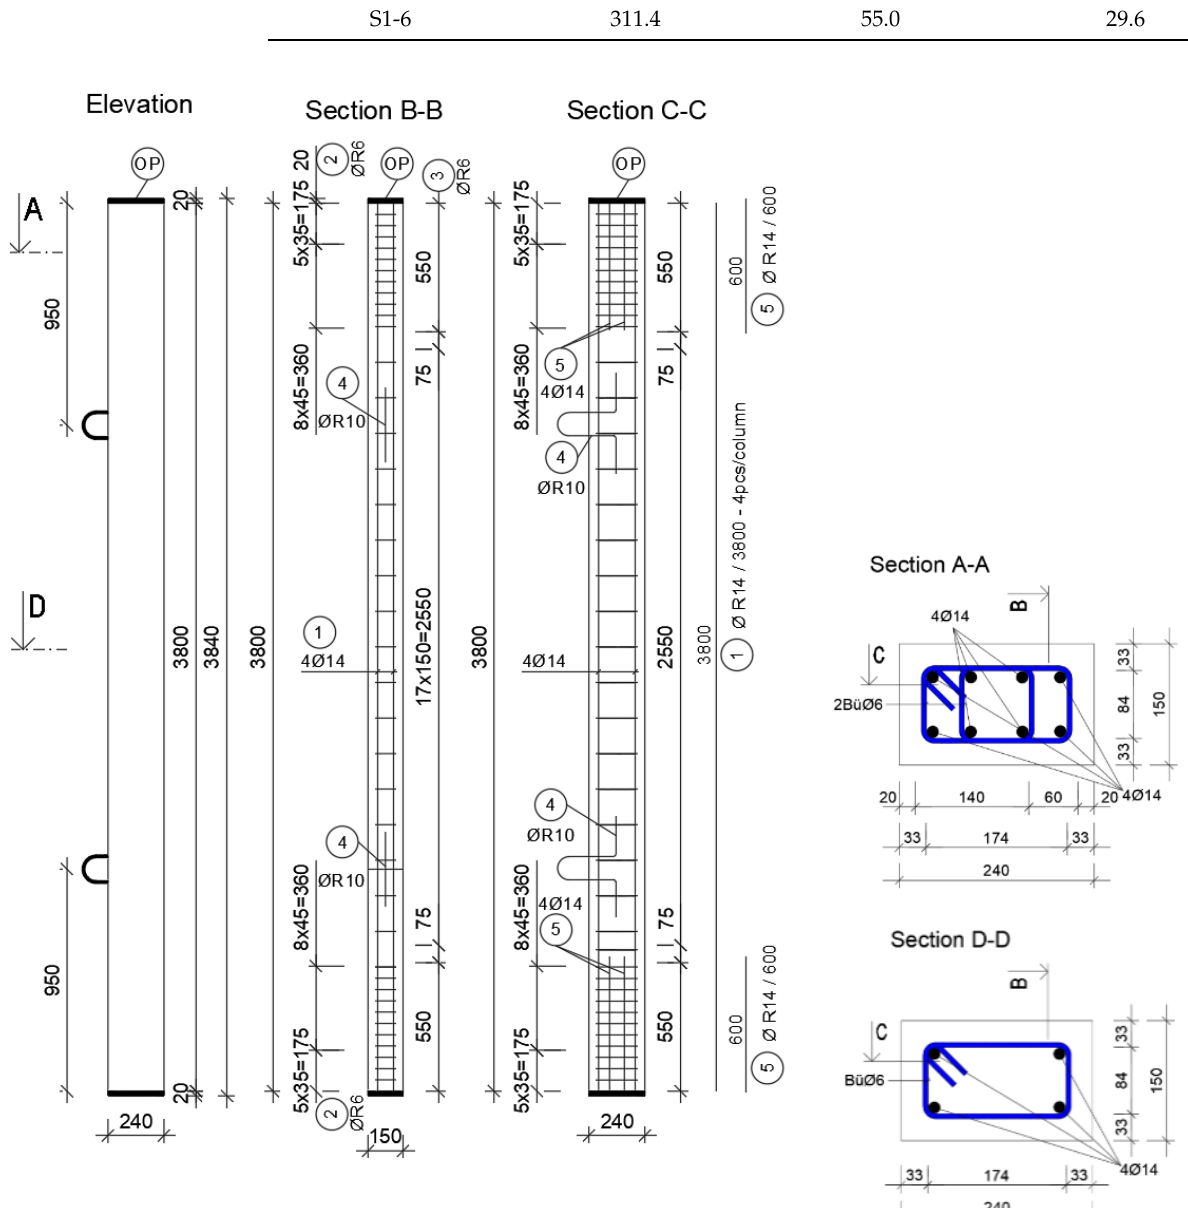
Figure 5. Reinforcement and formwork drawings of the investigated slender columns [5,6].